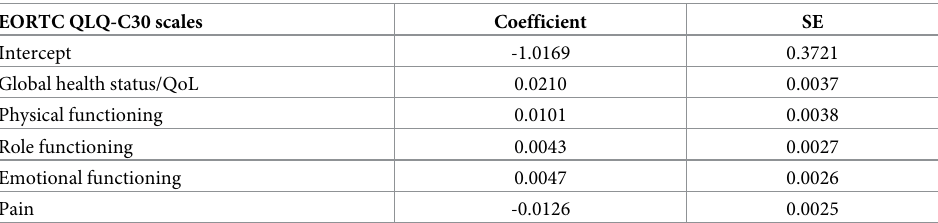
Table 4. Characteristics of the final model (Model 1d) without shrinkage.